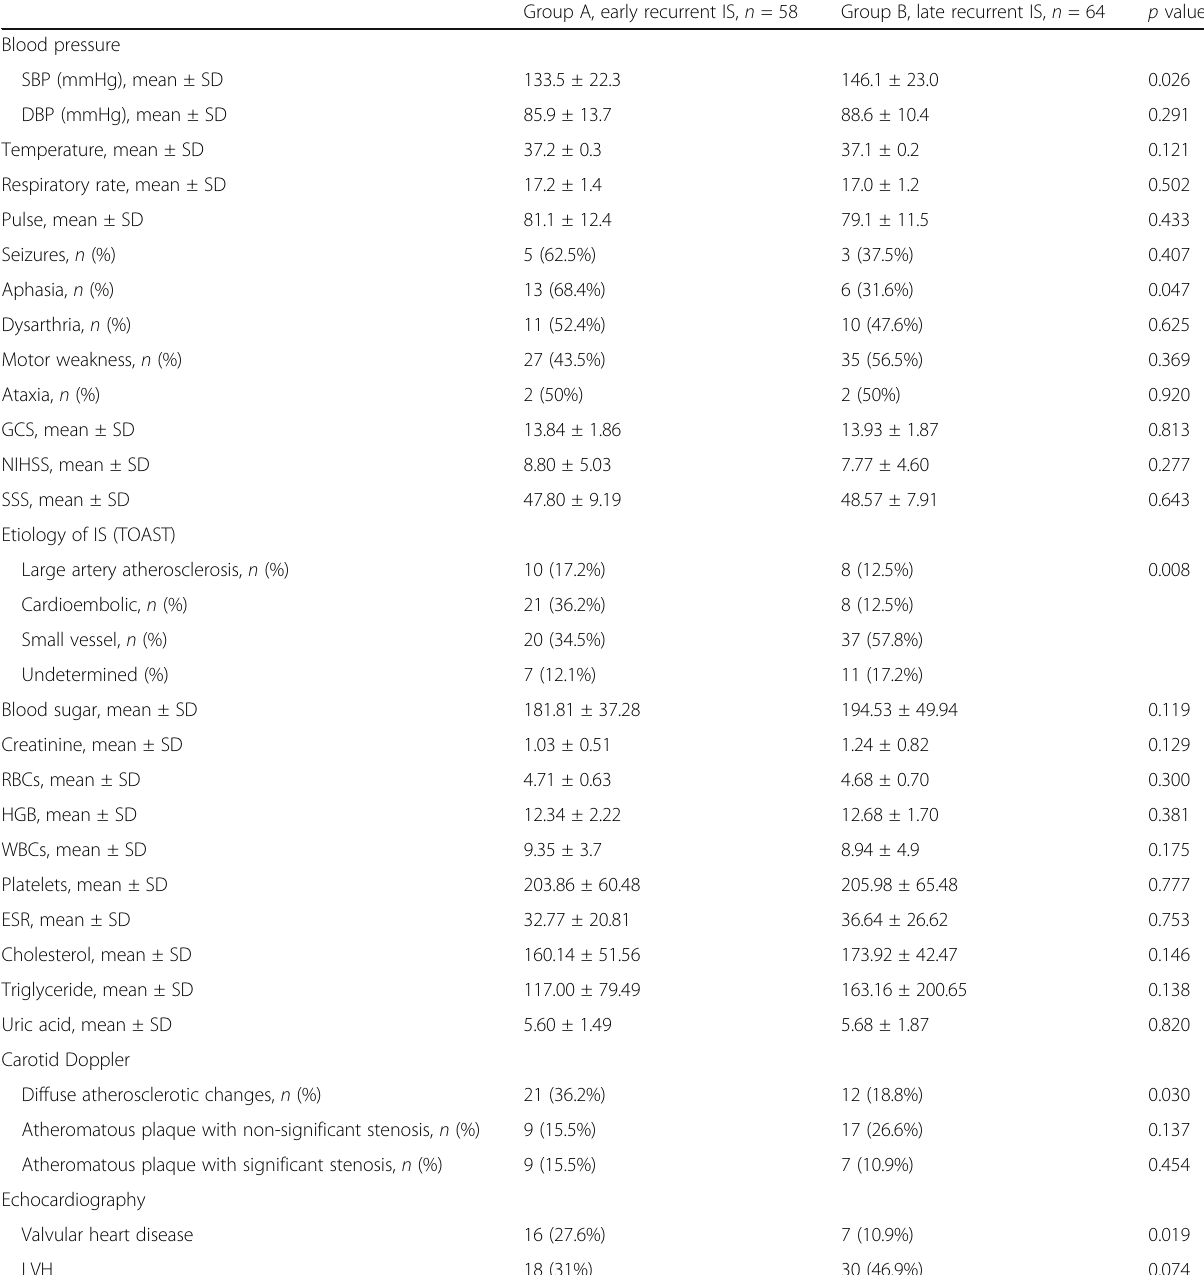
Table 3 Clinical, laboratory, and radiological data in both groups, on admission Group A, early recurrent IS, n = 58 Group B, late recurrent IS, n = 64 p